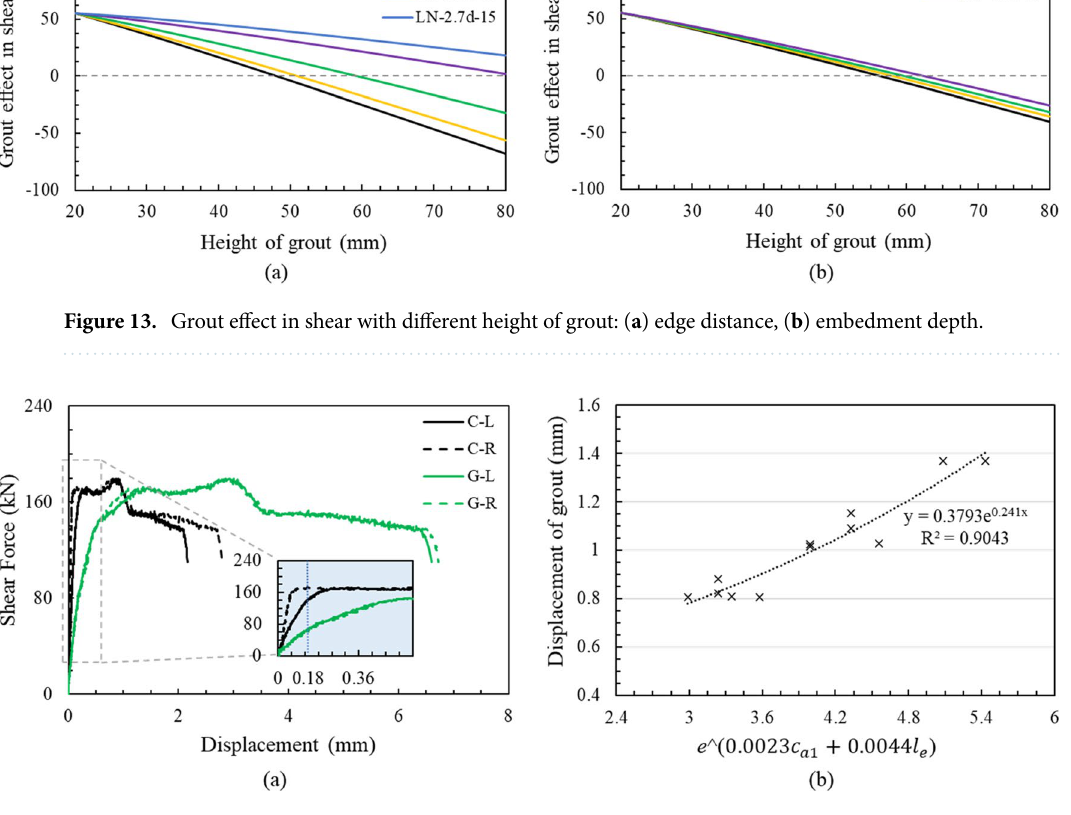
Figure 14. Displacement behavior of grout bedding and concrete pedestal: ( a ) load–displacement curve of LN-3.2d-15 specimen for grout and concrete, ( b ) displacement of grout due to edge distance and embedment